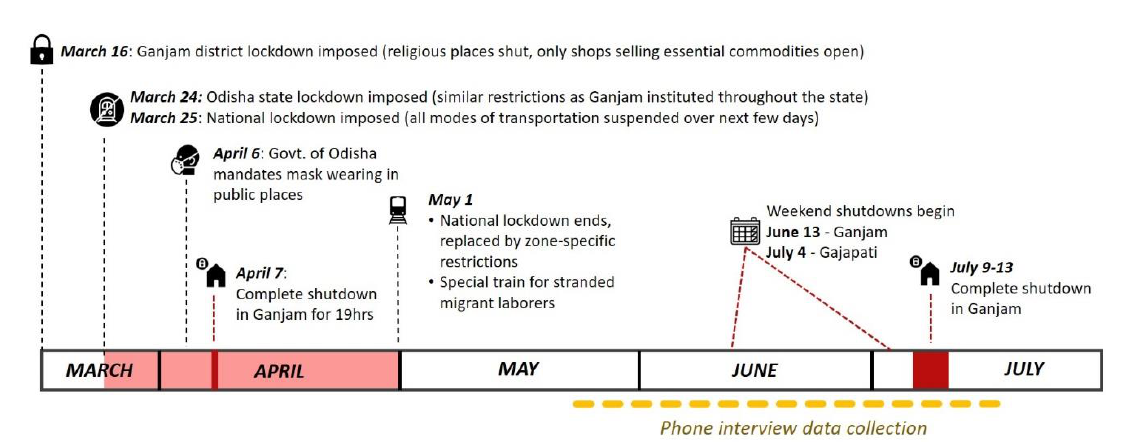
Figure 1. Timeline of local COVID-19 restrictions in relation to the data collection period for the semi-structured phone interviews.